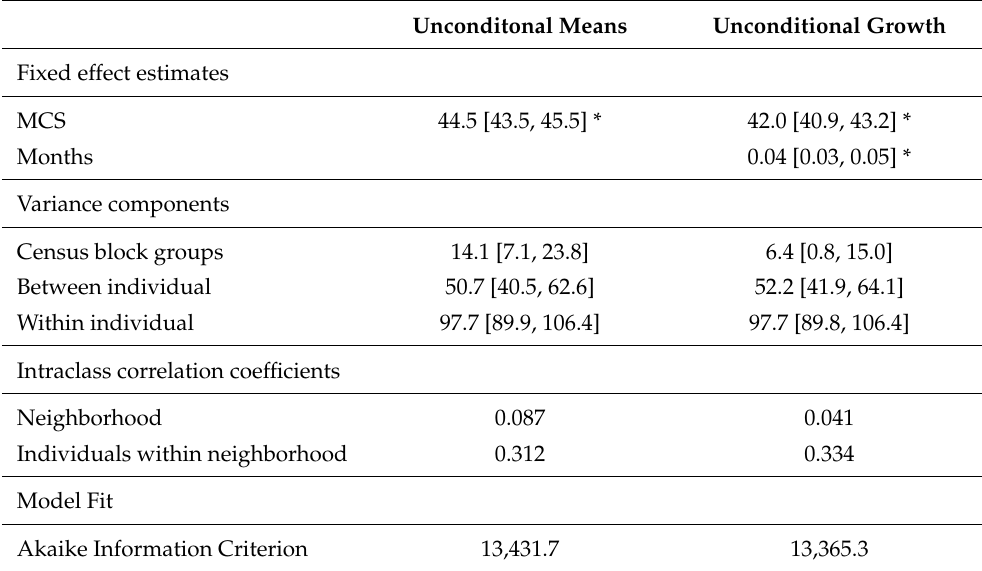
Table 2. The results of unconditional means model (no predictors included) and unconditional growth model (time variable included) describing the changes in mental health scores across the GCAFH study